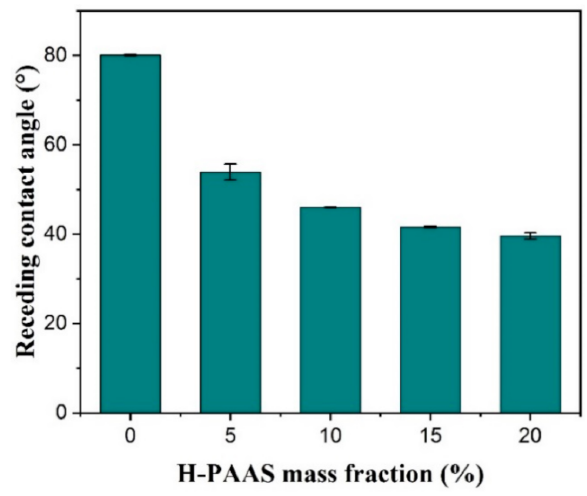
Figure 17. Receding contact angles of the surfaces of PP and PP-H-PAAS.